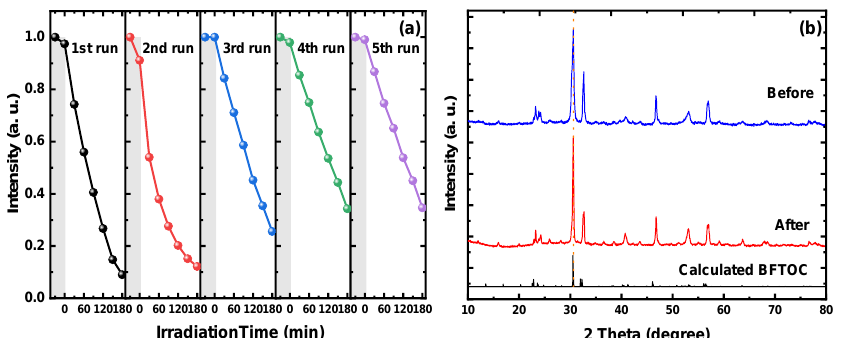
Figure 8. Time profiles of RhB degradation for five successive cycles with BFTOC in the photocatalytic process ( a ) and its XRD patterns ( b ).